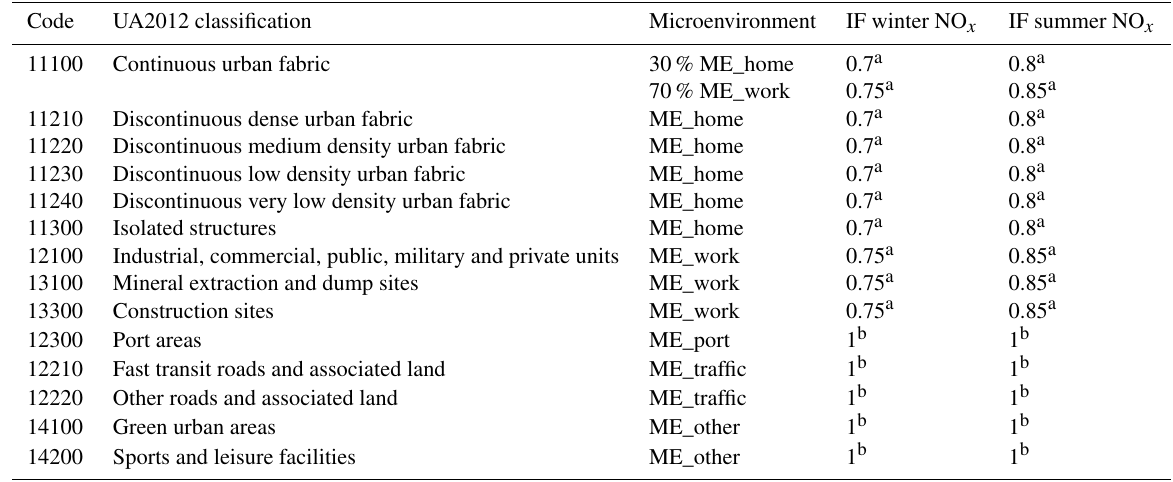
Table 2. Mapping of Urban Atlas 2012 classification with selected microenvironments and infiltration factors (IFs) for indoor–outdoor relationships in winter (September–February) and summer (March–August)